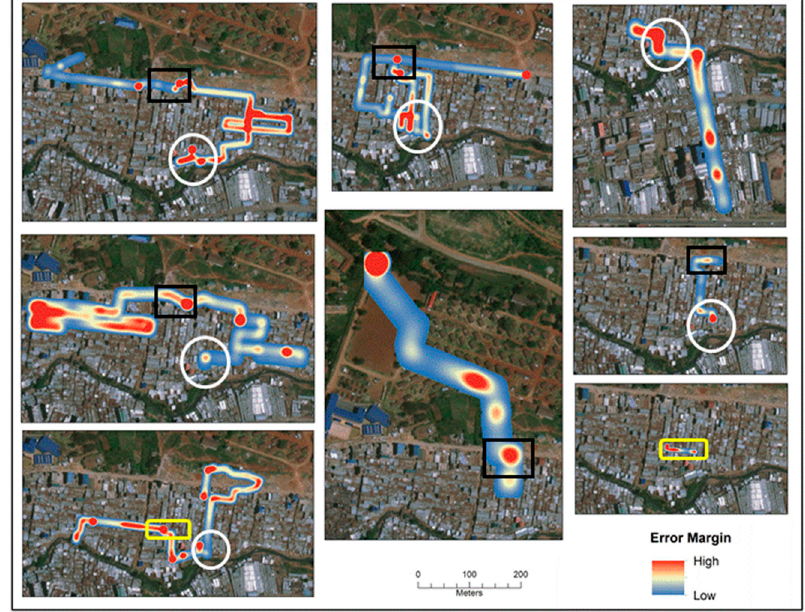
Figure 7 . Visualized error between actual and corrected coordinate paths for eight SV routes. The three shapes show the same location on the different maps.